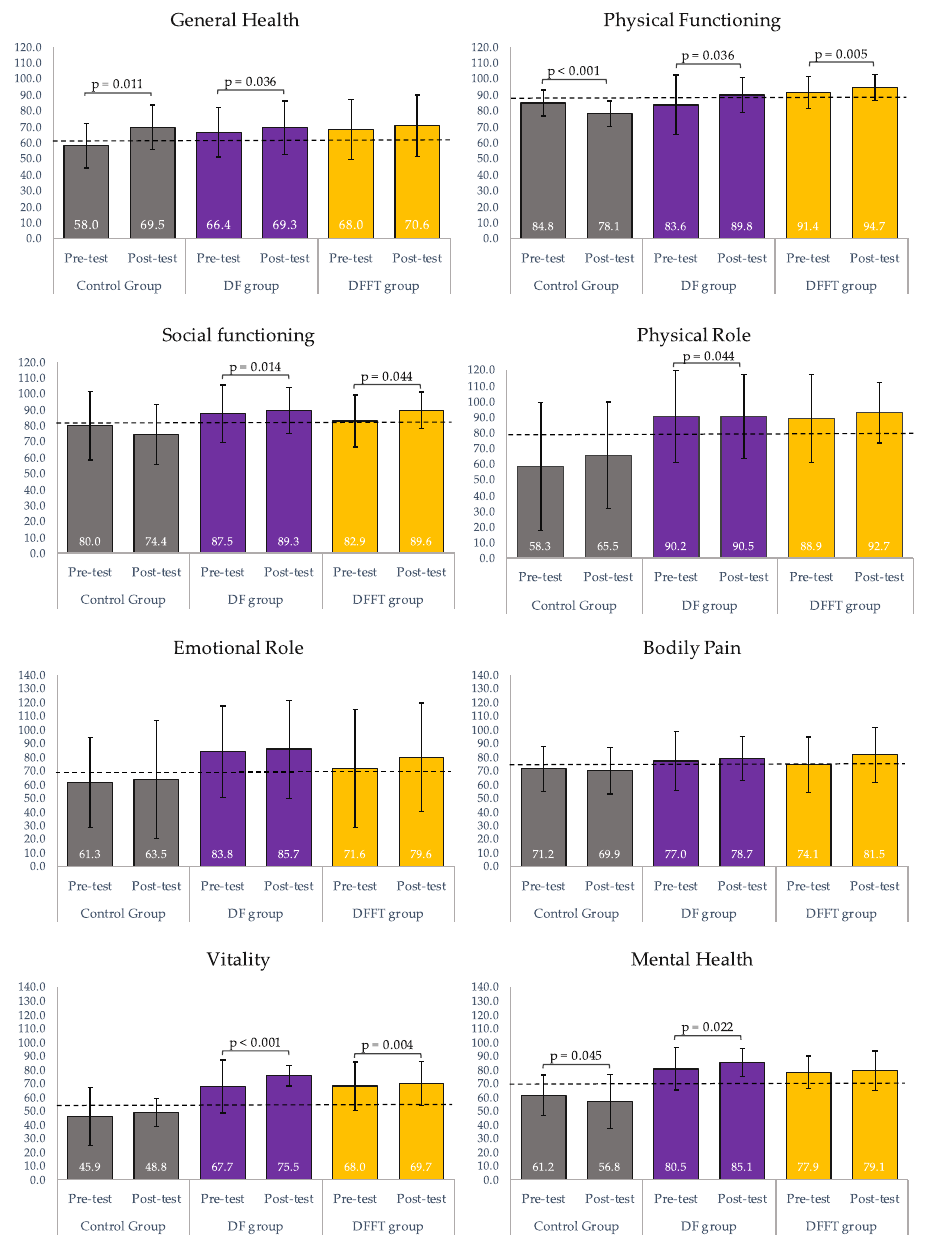
Figure 2. Changes in HRQoL dimensions from baseline to post-intervention within the study groups (mixed factorial ANOVA, Bonferroni post-hoc test for di ff erences pre-post within the groups). DF group = Dance Fitness group; DFFT = Dance Fitness and functional strength training group; Data are expressed as mean (M) and standard deviation (SD) based on marginal means and the following baseline leves of reference represented by discontinued line: GH = 62.14, PF = 86.30, SF = 80.68, PR = 80.45, ER = 69.05, BP = 74.07, V = 56.8, MH = 70.07.